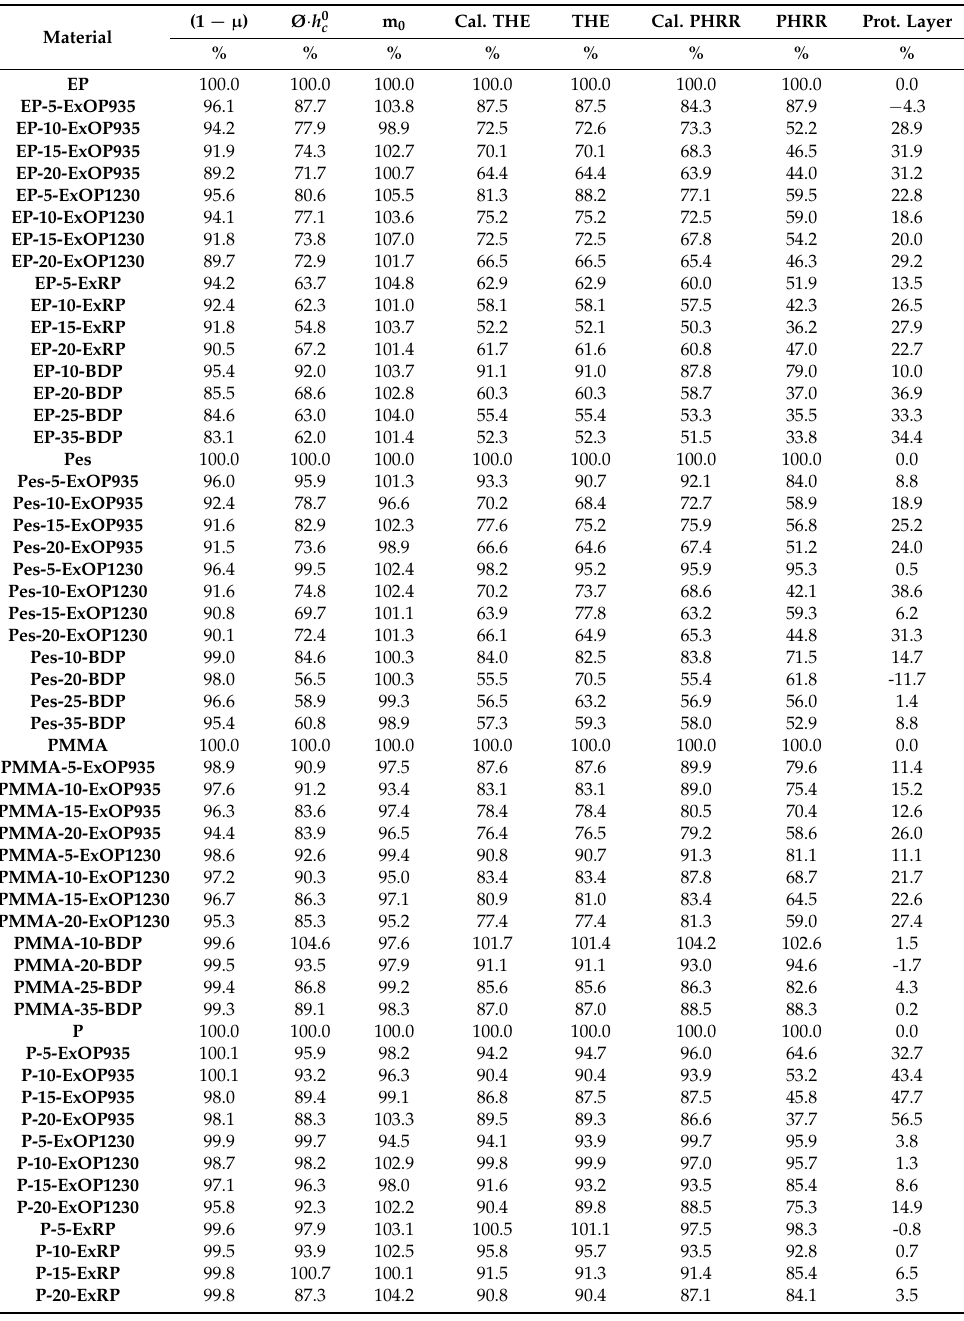
Table 4. Quantification of the reduction in THE and PHRR due to the flame retardancy modes of action: charring, gas phase action, and residual protection layer for all of the examined